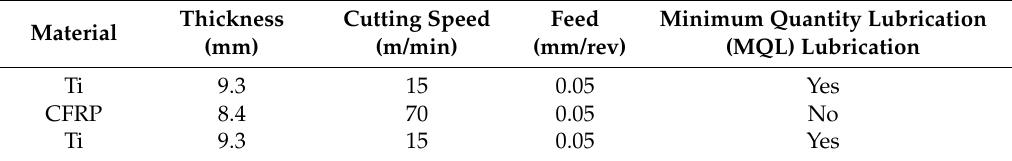
Table 1. The stack configuration and cutting parameters tested.